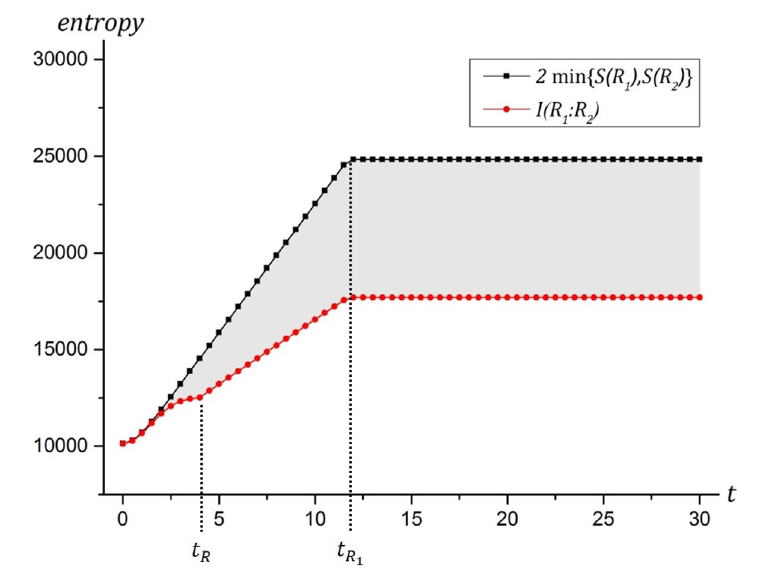
Figure 23 . The upper bound 2 min { S ( R 1 ) , S ( R 2 ) } and the lower bound I ( R 1 : R 2 ) of reflected entropy between R 1 and R 2 . We pick b 1 = 0 . 01 , b 2 = 5 , φ r = 10 , S 0 = c = 2000 and (cid:15) UV = 0 . 001 . Typical time scales are denoted in the figure: t R , t R denote the Page time for R 1 and R 1 ∪ R 2 1 while R 2 does not have an island for these